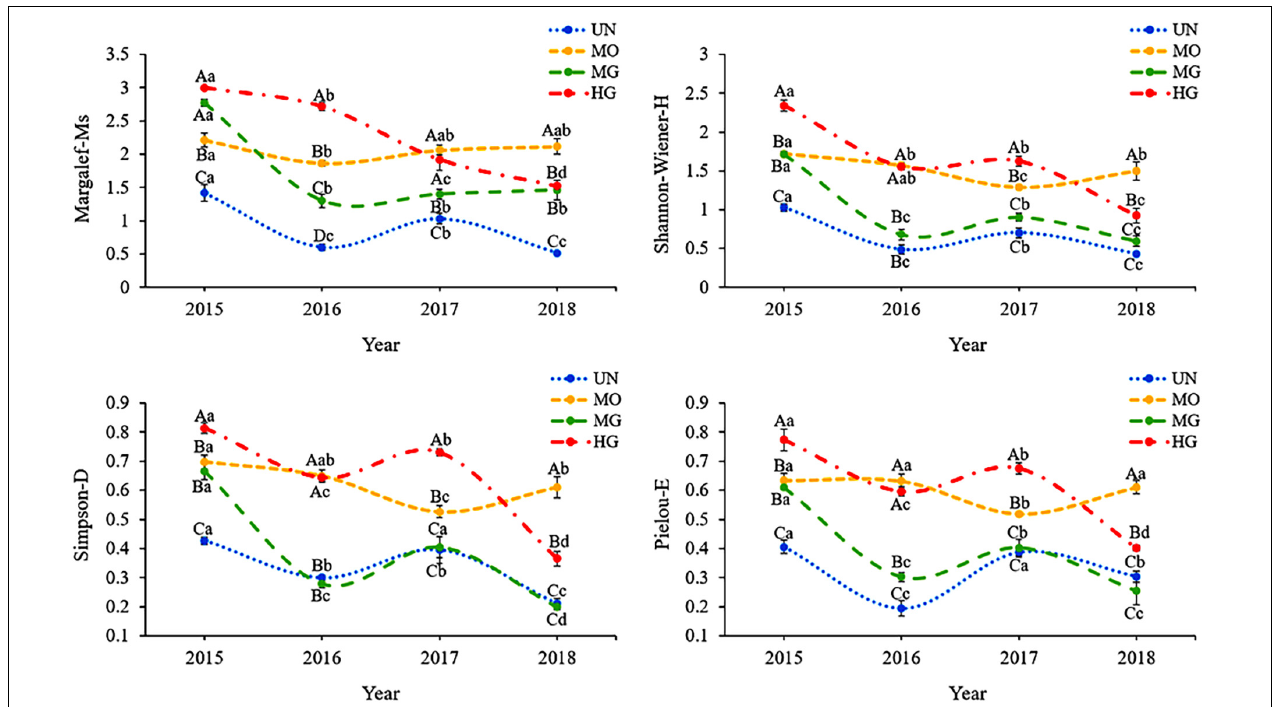
FIGURE 2 | Interannual variation in grassland plant diversity under different utilization patterns. Different capital letters indicate significant differences in a plant diversity index among sites in the same year at the 0.05 level, and different lowercase letters indicate significant differences in a plant diversity index between years within a